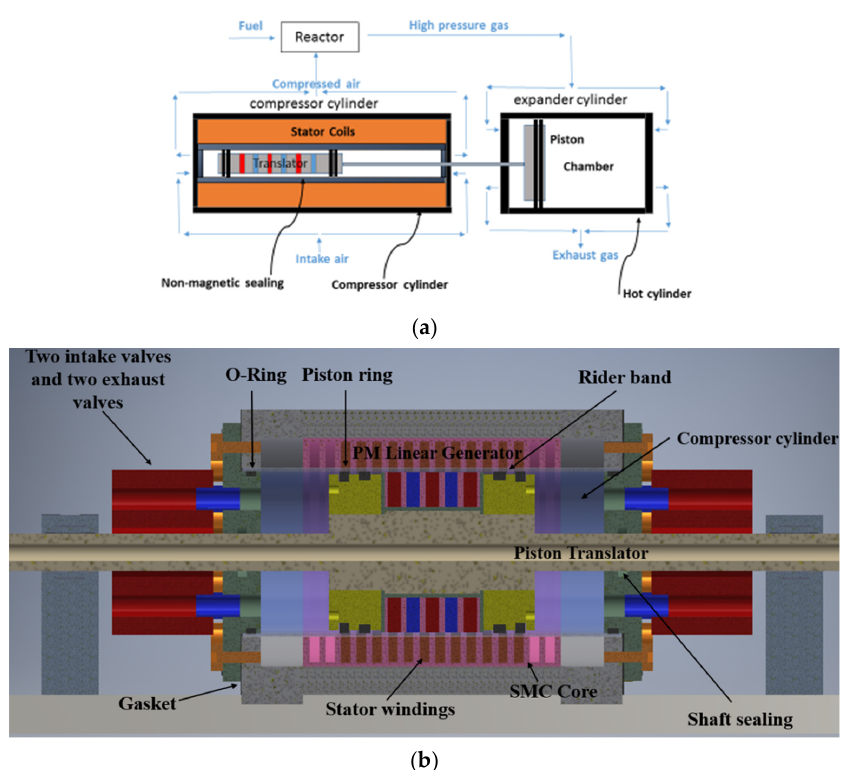
Figure 22. FPEG system. ( a ) Proposed integrated design of FPEG system. ( b ) Integrated compressor- generator prototype parts. generator prototype